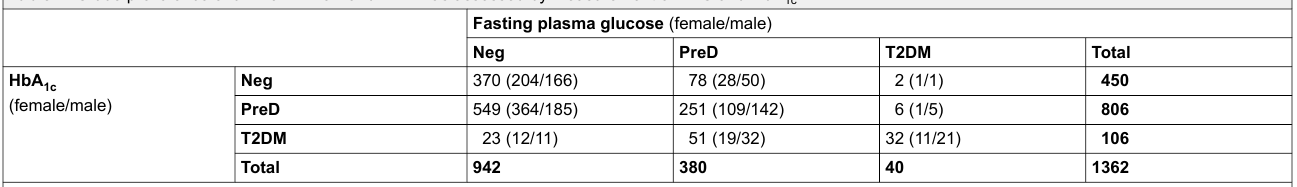
Table 2: Crude prevalence of unknown PreD and T2DM as assessed by measurement of FPG and HbA 1c